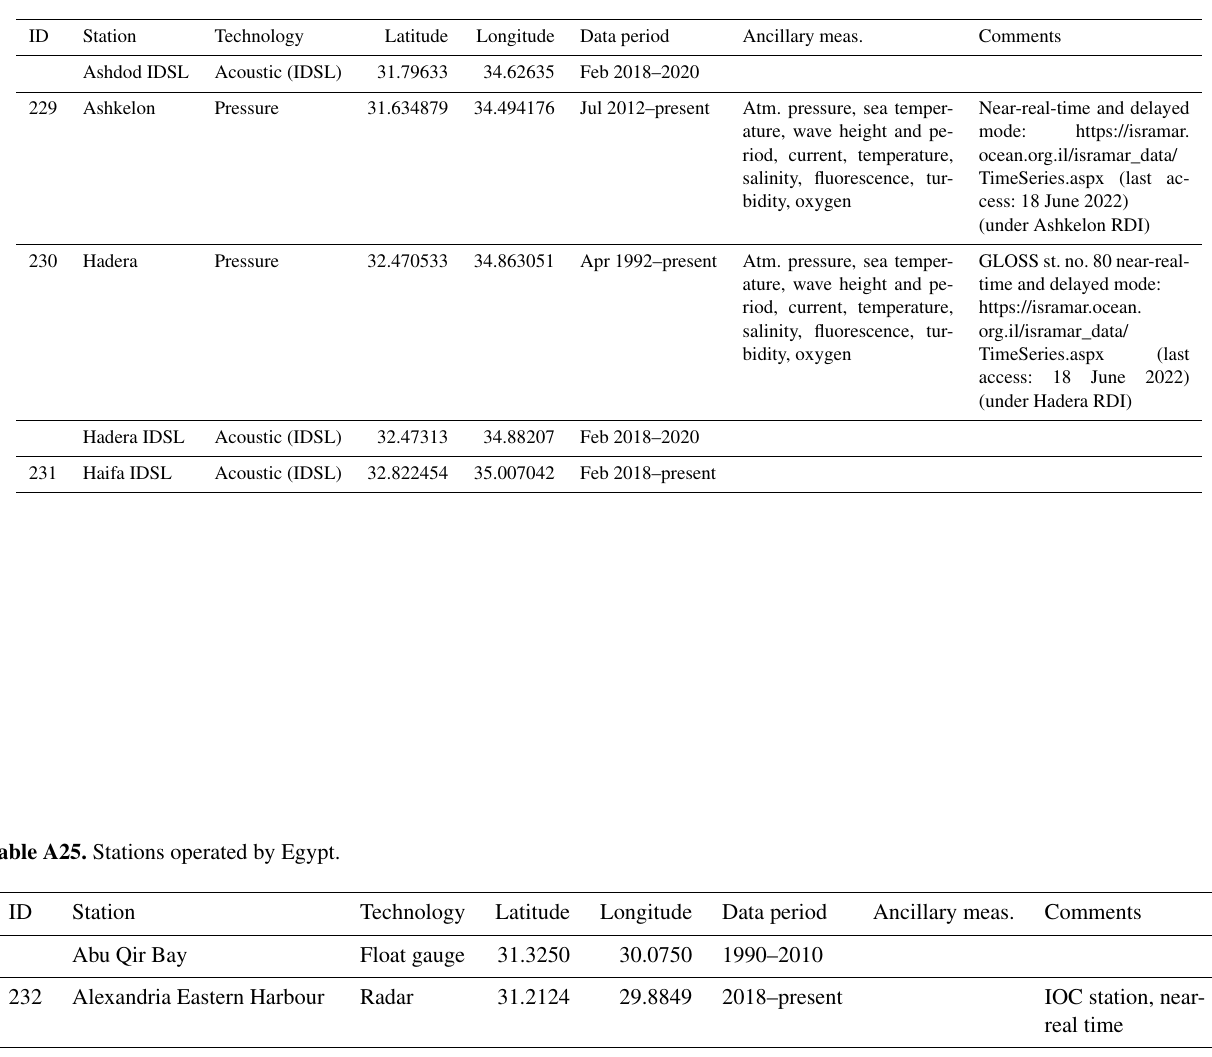
Table A24. Tide gauge stations in Israel, operated by the National Institute of Oceanography, Israel Oceanographic and Limnological Re- search.